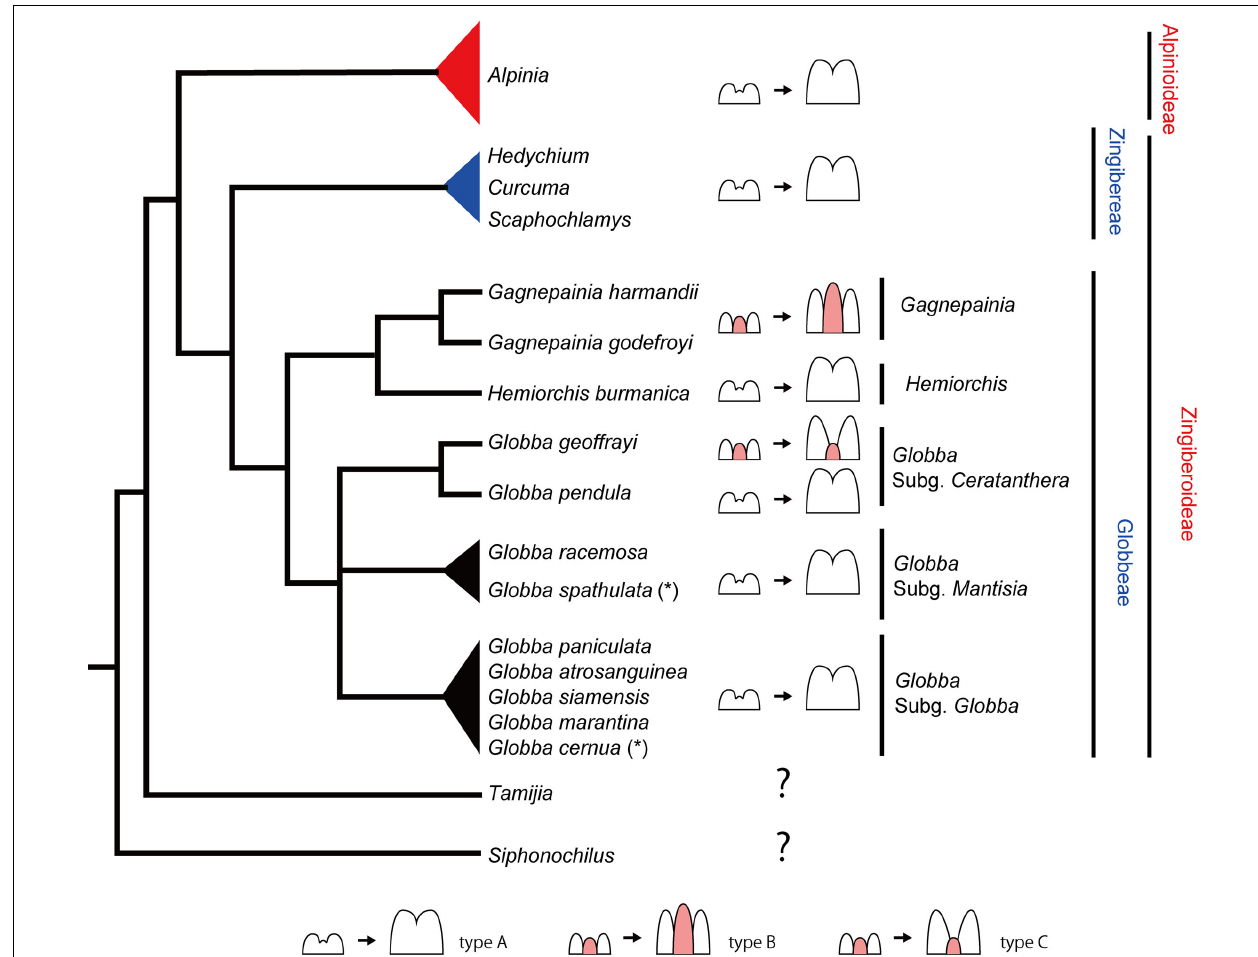
FIGURE 12 | The evolution of labellum development in Globbeae. Mapping the labellum development on a simplified phylogenetic tree of the tribe Globbeae based on Cao et al. (2019). The phylogenetic position of Zingibereae, Alpinioideae, Tamijia , and Siphonochilus are based on Kress et al. (2002) and Cole (2018). Pink highlighted portion in each schematic diagram of labellum development represents the missing fifth staminode. Note that the small bump between bilobed primordia of the left drawing of type A may not be the fifth staminode; therefore, it is not highlighted in pink. For Globbeae, observed species in this study and two species adapted from Box and Rudall (2006) are mapped on the tree, although they do not cover all species included in the original tree of Cao et al. (2019) (some species missing in subgenus Mantisia and Globba , represented by black triangles). (*) represents a species based on Box and Rudall (2006). The references for the labellum development in Zingibereae and Alpinioideae are as follows: Alpinia , Song et al. (2007); Curcuma , Fukai and Udomdee (2005); Hedychium , Kirchoff (1997); and Scaphochlamys , Kirchoff